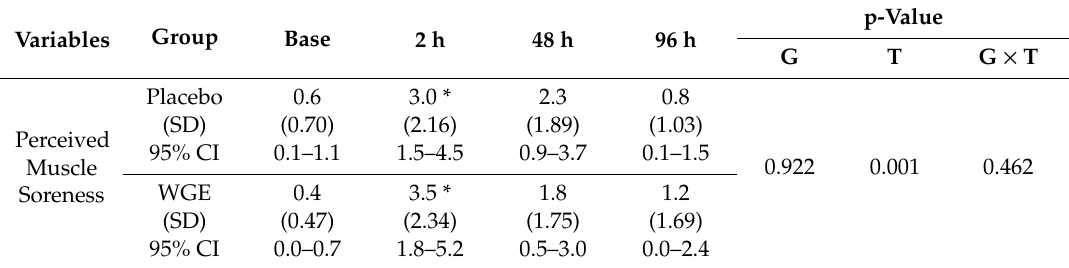
Table 5. The results of perceived muscle soreness following acute eccentric exercise.